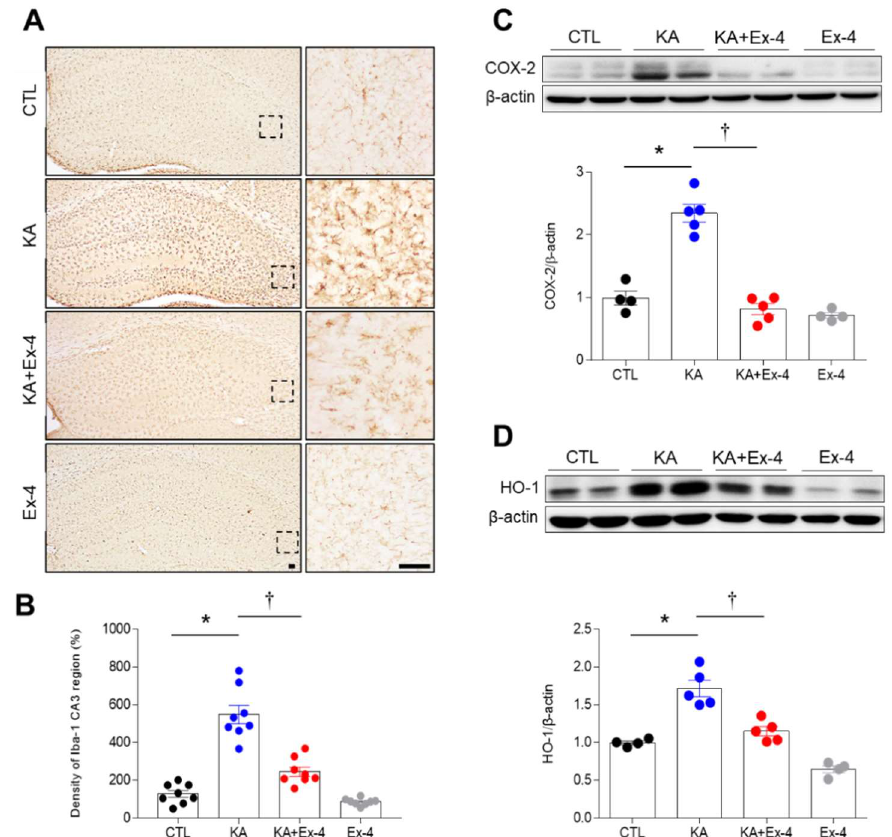
Figure 4. Effects of Ex-4 pretreatment on neuroinflammation in the hippocampus of KA-treated mice. ( A ) Representative images of Iba-1 immunohistochemistry are shown in the hippocampal CA3 region 24 h after KA treatment ( n = 3–4 mice per group). The areas in dotted squares in the left panel are magnified on the right panel. Scale bar = 50 µm. ( B ) Quantitative result of Iba-1 positive cells are shown in 8-10 CA3 regions ( n = 3–4 mice per group). ( C , D ) Western blot analysis of hippocampal COX-2 ( C ) and HO-1 ( D ) protein expressions. Densitometric values for COX-2 and HO-1 were nor- malized to β-actin levels ( n = 4–5 mice per group). Data are presented as mean ± SEM. * p < 0.05 vs. CTL, † p < 0.05 vs. KA. The one-way ANOVA was used to detect any statistically significant differ- ences between groups ( B – D ). B; p values = 0.0001 (KA), 0.0001 (KA + Ex-4), F (3, 28) = 52.26, COX-